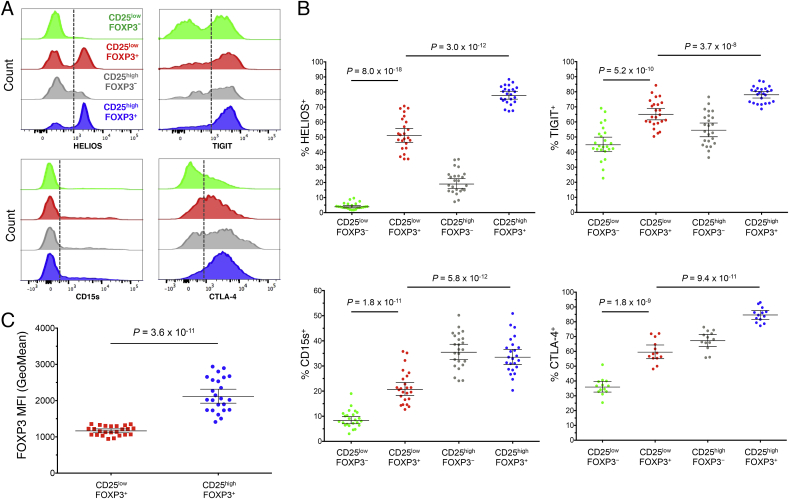
CD25lowFOXP3+cells show reduced expression of several conventional Treg markers. (A) Representative histograms depict the distribution of the expression of the conventional Treg markers HELIOS, TIGIT, CD15s and CTLA-4 amongst: (i) CD127lowCD25lowFOXP3− (highlighted in green), (ii) CD127lowCD25lowFOXP3+ (highlighted in red), (iii) CD127lowCD25highFOXP3- (highlighted in grey), and (iv) CD127lowCD25highFOXP3+ (highlighted in blue) memory CD4+ T cells. (B) Scatter plots depict the distribution (geometric mean ± 95% CI) of HELIOS (n = 24), TIGIT (n = 24), CD15s (n = 24) and CTLA-4 (n = 13) in the CD45RA− compartment of the four assessed immune subsets. (C) Expression of FOXP3 (geometric mean ± 95% CI) was measured in the CD25lowFOXP3+ (depicted by red squares) and CD25highFOXP3+ (depicted by blue circles) subsets from 24 healthy donors. P values were calculated using two-tailed paired t-tests comparing the assessed immunophenotypes between CD25lowFOXP3+ and the other three delineated subsets from the same individual. P values < 0.005 were considered significant (Bonferronni correction for the comparison of ten independent immune markers between CD25lowFOXP3+ and CD25highFOXP3+ T cells). MFI, mean fluorescence intensity.